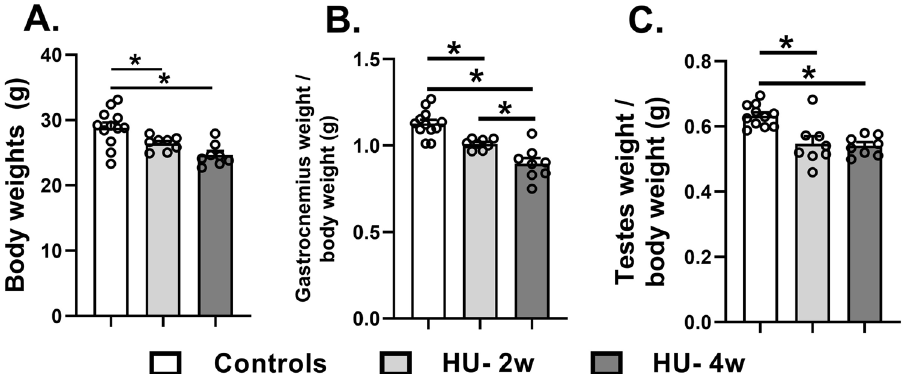
Figure 1. Bodyweight ( A ), and the weights of gastrocnemius muscle ( B ), and testes normalized to body weights ( C ) in ground-based controls and HU mice suspended for 2 and 4 weeks. Data is represented as mean ± SEM (n = 8–12/group). One-way analysis of variance, *p < 0.05.